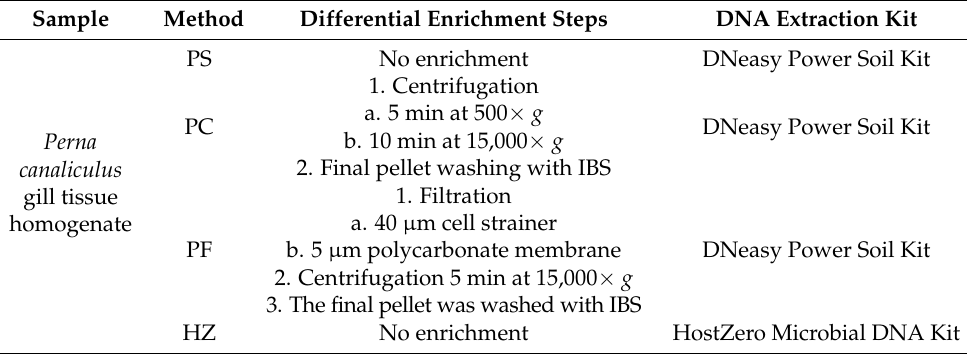
Table 1. The workflows of four methods. The homogenized gill tissue of Perna canaliculus was divided into four groups and the total DNA was extracted using four different methods, including direct extraction using PowerSoil DNA extraction kit (PS), extraction using PowerSoil DNA extraction kit after differential centrifugation (PC), extraction using PowerSoil DNA extraction kit after filtration (PF), and direct extraction using HostZERO microbial DNA kit (HZ). IBS represents imidazole- buffered